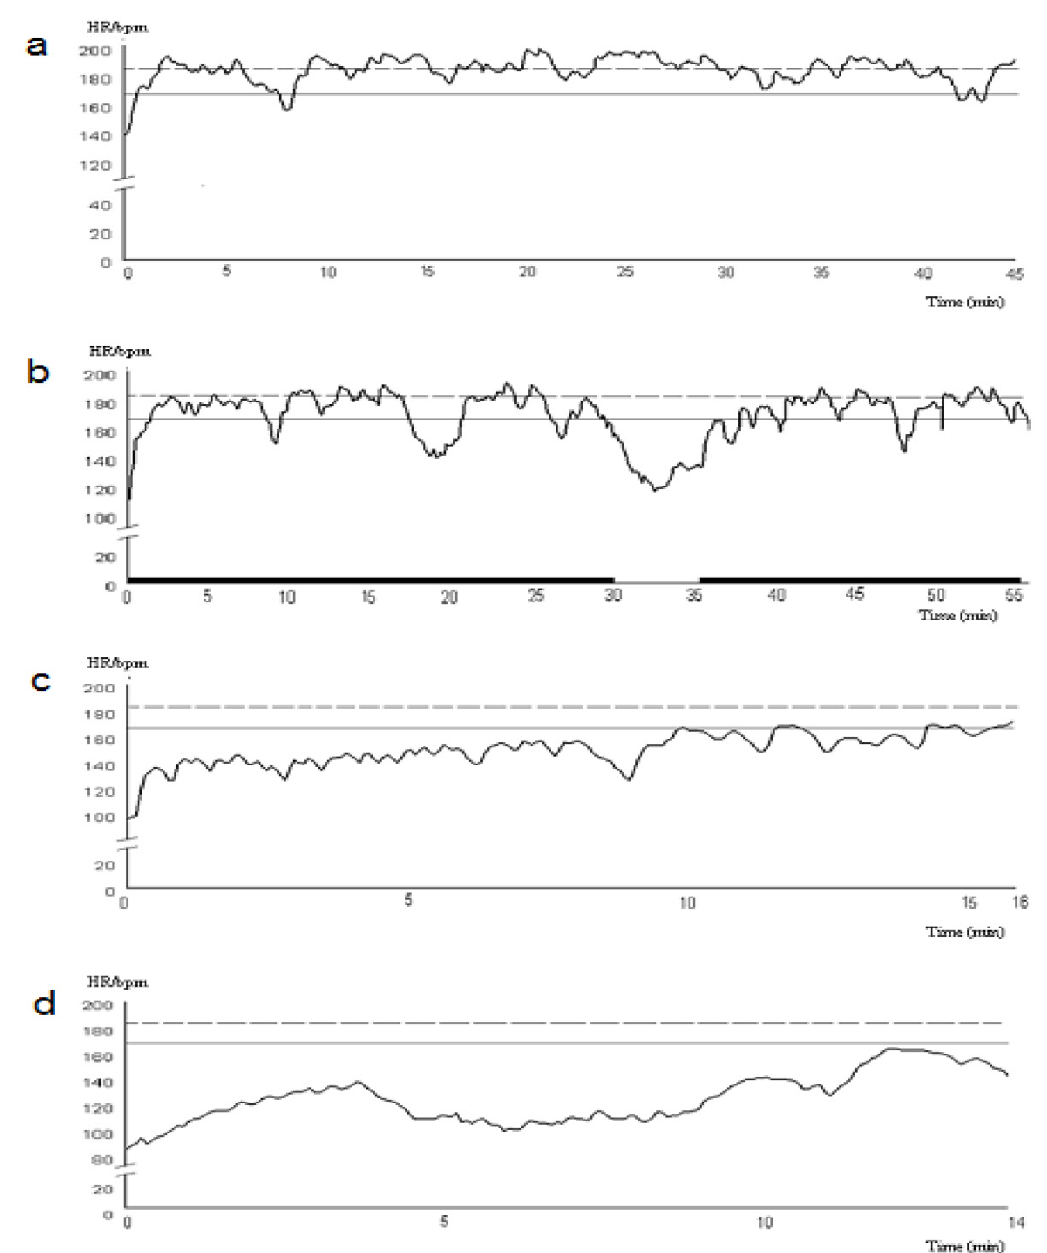
Figure 2. HR (bpm) response of a single player during several different training sessions (a. friendly match; b. training match; c. tactical workout; d. technical workout). The two lines (dotted and continuous traces) refer to the HR corresponding to the blood lactate concentrations of 4 mmol/L and 2 mmol/L, respectively. During the training match, bold line next to the time line represents the stimulus